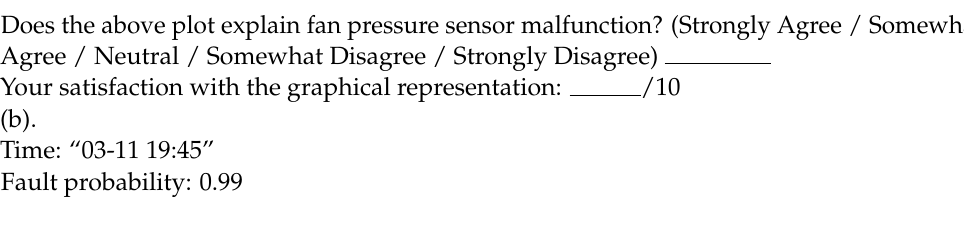
Figure A2. Fan pressure sensor malfunction. SHAP explanation for fault at a specific